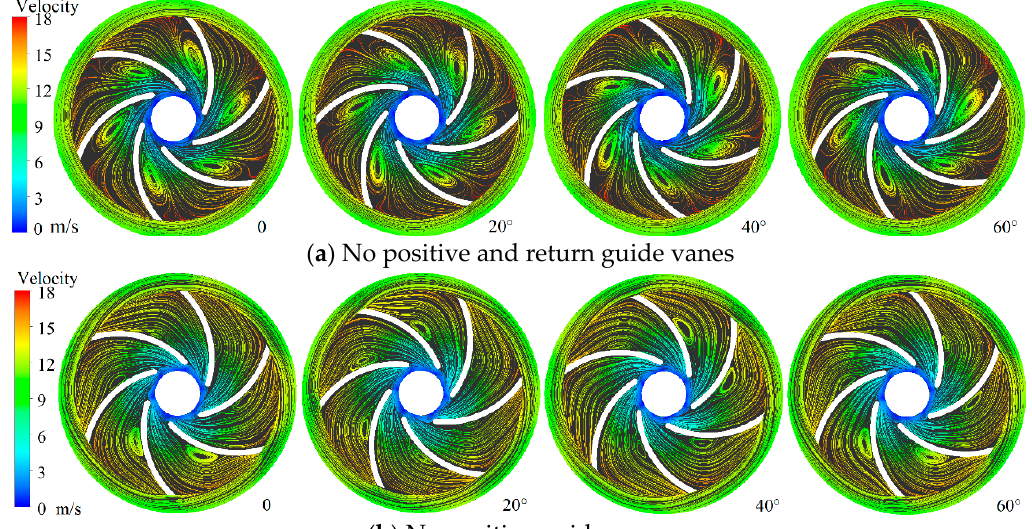
Figure 8. Frequency response curves of the hydroacoustic sound pressure level (SPL) of the impeller with different blade numbers of the guide vane.